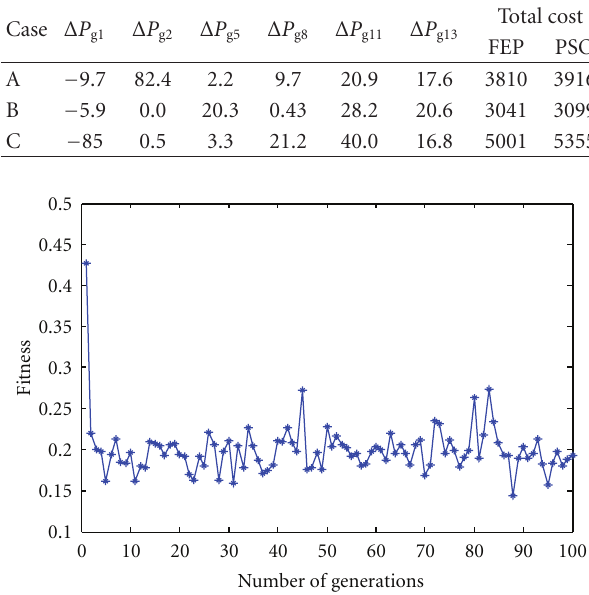
Figure 4: Convergence characteristics for Case A.